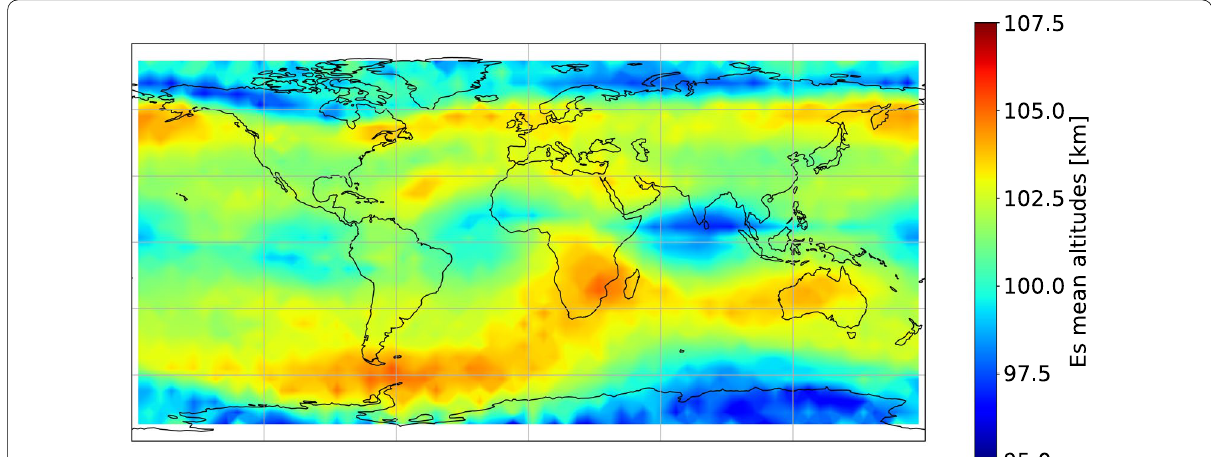
Fig. 4. As expected, Es layers concentrate mostly between 100 km and 105 km with slight variability. Remark- able is that, again, the equatorial region shows a deviat- ing pattern. Here, Es layers are detected in the mean at lower altitudes compared to the mid-latitude region. In the Indian region, we find the lowest Es altitudes on the globe except for the polar region, which raises the ques- tion of its